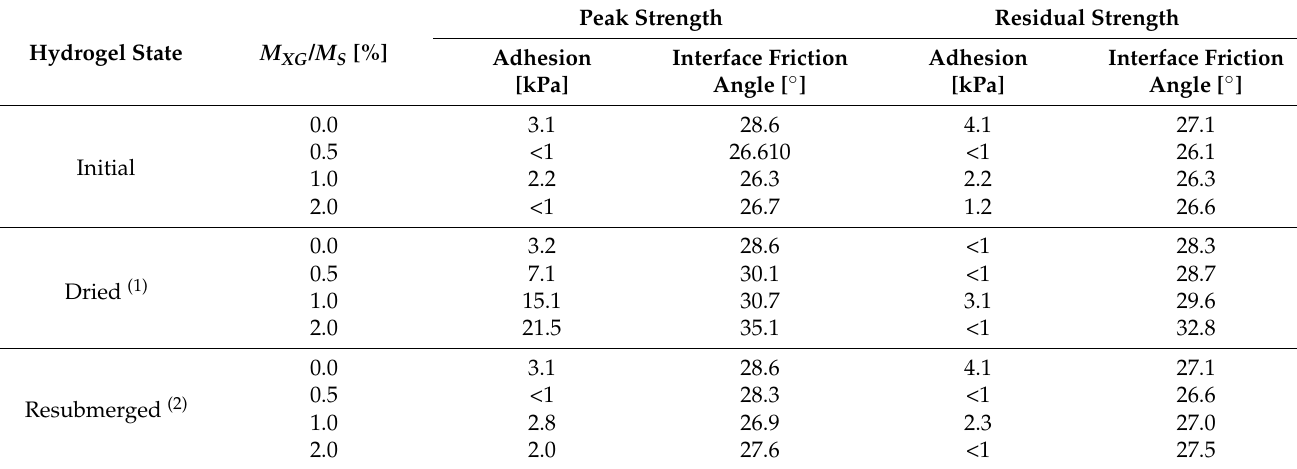
Table 5. Mohr–Coulomb failure parameters determined from linear regression ( Interface I